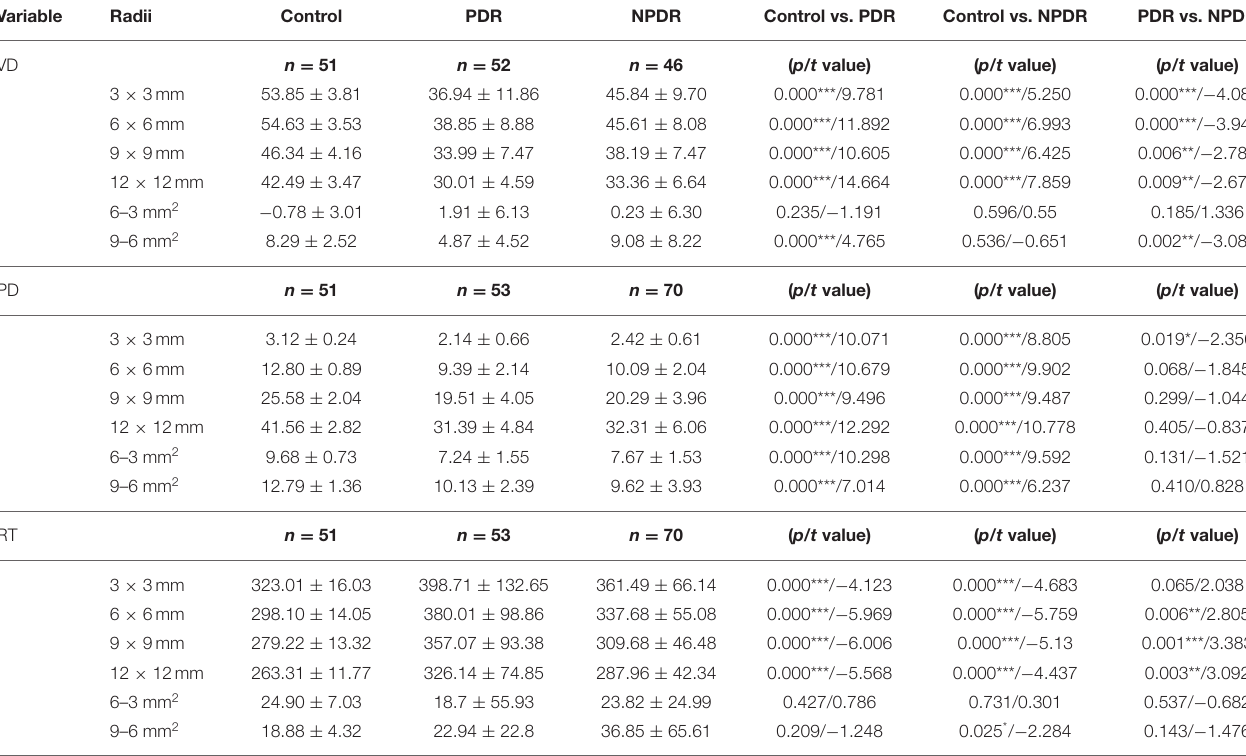
TABLE 2 | SS-OCTA evaluated the deep vascular complex with different radii centered on the macular fovea in control eyes, PDR eyes, NPDR eyes (mean ± SD, p -value).